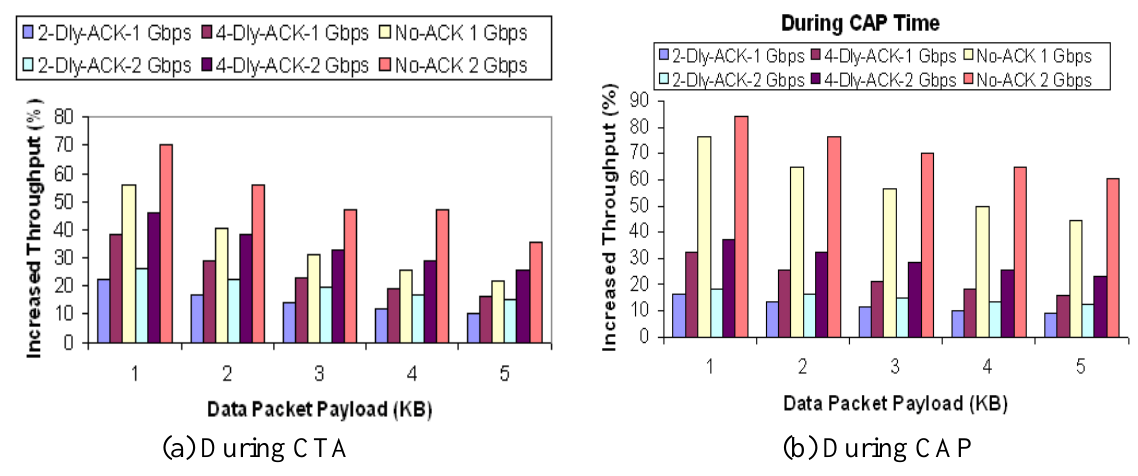
Figure 10. Increment in